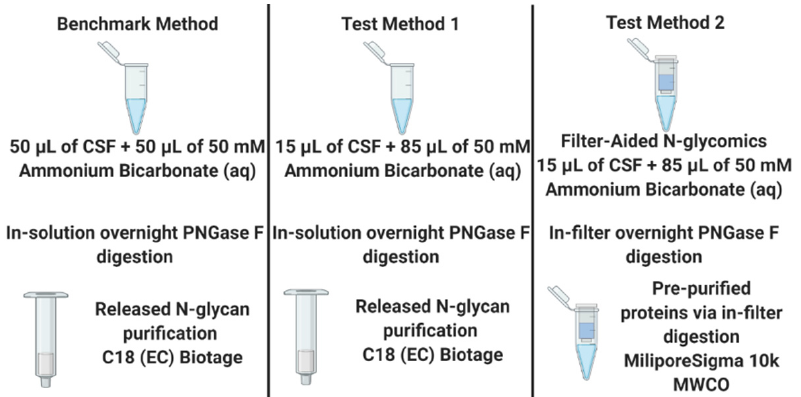
Figure 4. Workflows describing each method of releasing N -glycans from CSF as well as purification steps. The benchmark method was the method previously published by Cho et al., and the other two test methods were one in-solution digestion with 15 µ L of CSF and one Filter-Aided N -Glycan Separation technique with 15 µ L of CSF.